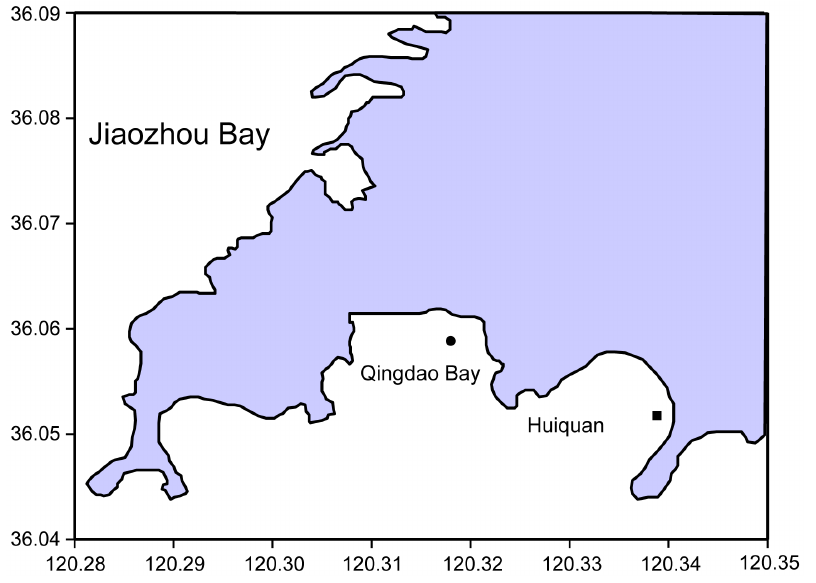
N , natural intertidal eelgrass bed in Qingdao Bay.